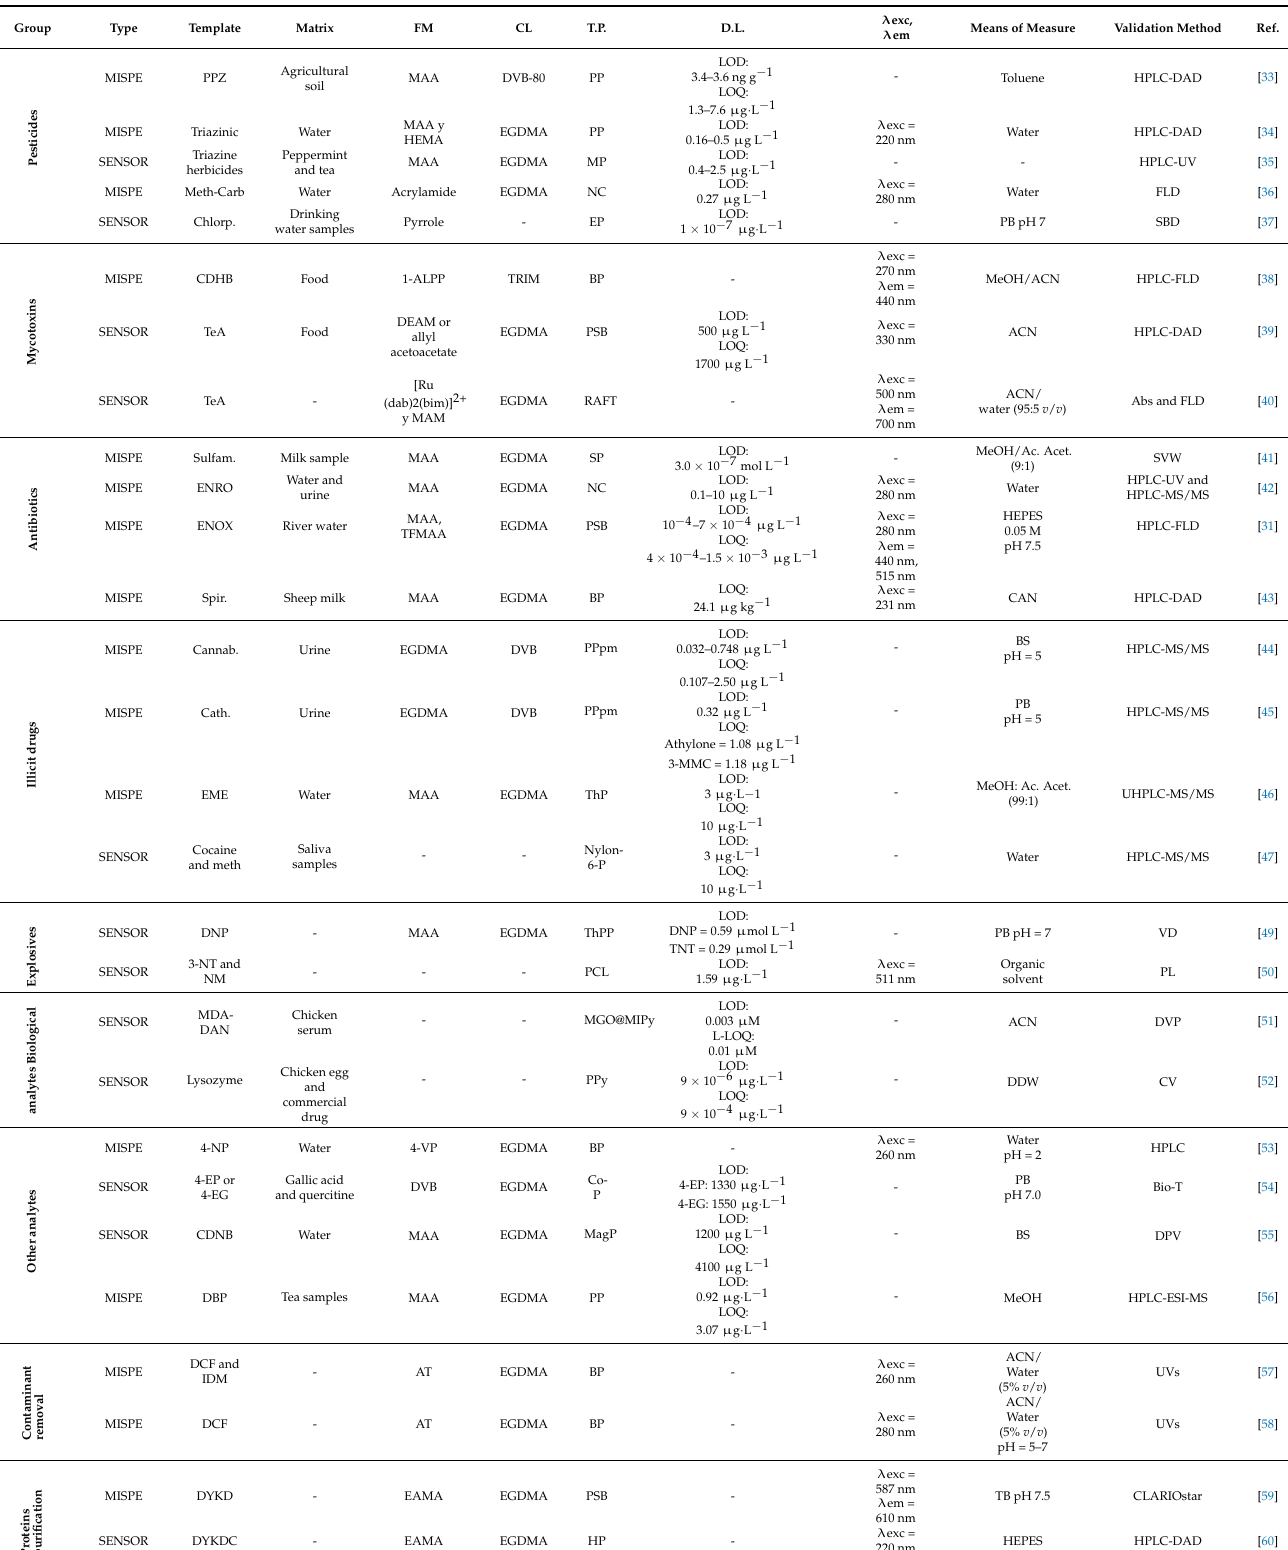
Table 1. Summary of the applications of molecularly imprinted polymers in Spain in recent